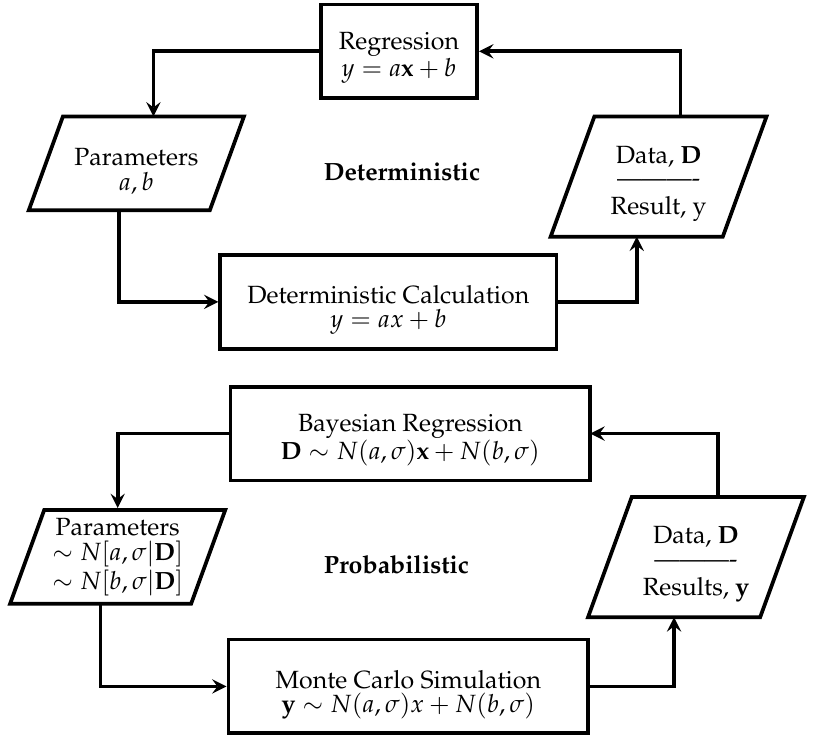
Figure 1. Deterministic and probabilistic calculation, simulation, and inverse modelling. The